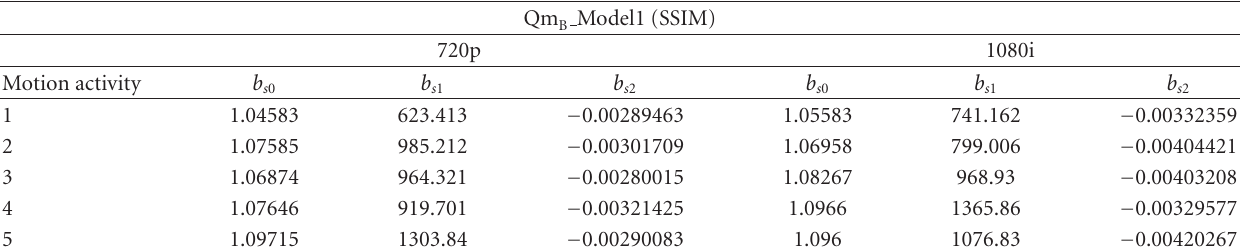
Table 5: Coe ffi cients for the first model of Qm B .